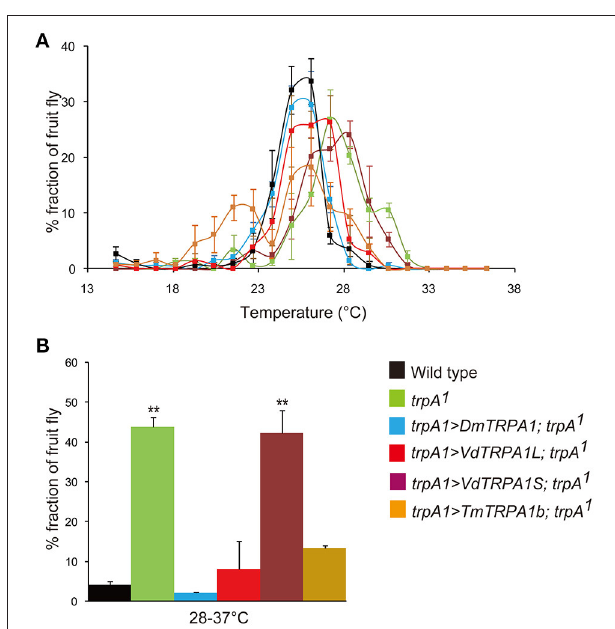
FIGURE 2 | VdTRPA1L and TmTRPA1b are able to complement the functions of DmTRPA1 for thermotactic behavior of Drosophila melanogaster . (A) The distribution of wild type, trpA1 1 , and trpA1 1 expressing either DmTRPA1 (trpA1 > DmTRPA1; trpA1 1 ), VdTRPA1L (trpA1 > VdTRPA1L; trpA1 1 ), VdTRPA1S (trpA1 > VdTRPA1S; trpA1 1 ), or TmTRPA1b (trpA1 > TmTRPA1b; trpA1 1 ) under trpA1-Gal4 was recorded along a thermal gradient (14–37 ◦ C). The recording was repeated three times for each group. The mean value with error bar ( ± SEM) is shown for each temperature section. (B) The percentage of fruit flies in the area of 28–37 ◦ C (Wild type: 4.1 ± 0.9%; trpA1 1 : 43.8 ± 2.5%; trpA1 1 expressing DmTRPA1: 2.0 ± 0.4%; trpA1 1 expressing VdTRPA1L: 8.0 ± 7.1%; trpA1 1